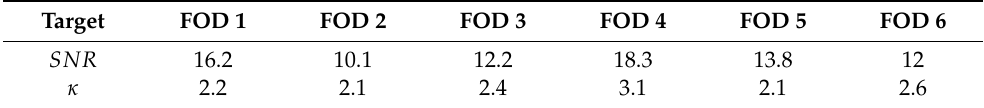
Table 2. Super-resolution ratio statistics of the FOD targets in Scene